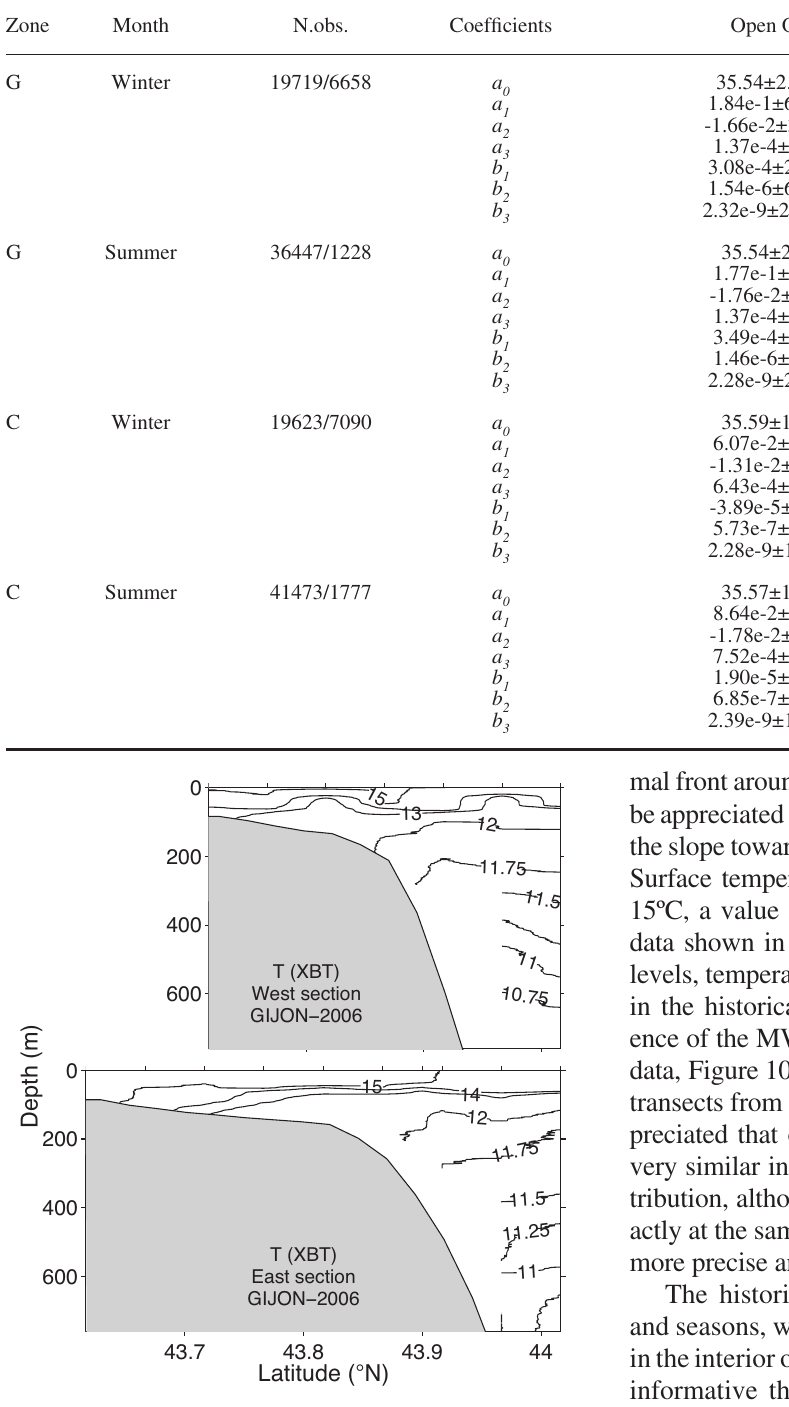
Fig . 9. – Vertical sections of temperature (ºC) measured by XBTs during the GIJON-2006 field exercise in the western and eastern